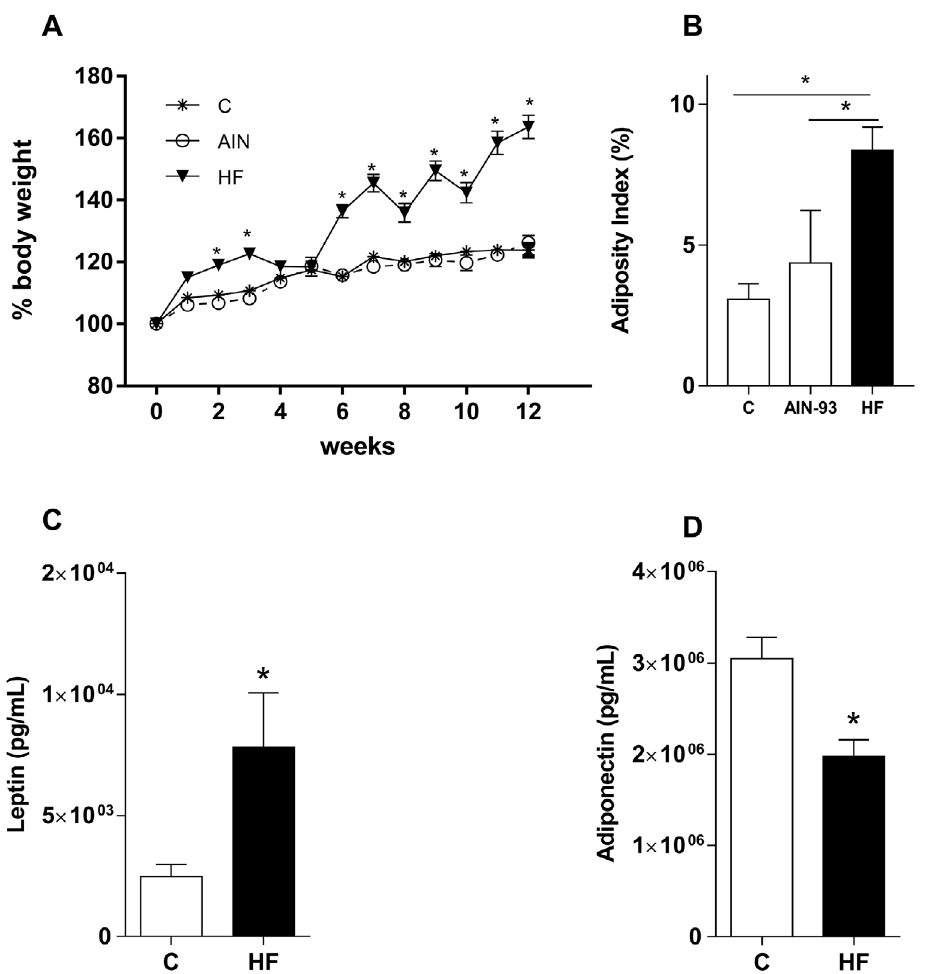
Figure 1- Mice fed HF diet presented body weight gain, increased adiposity, and alteration in the leptin and adiponectin concentrations. A: Weight parameters measured for 12 weeks, once a week, in groups of mice fed with control chow, AIN-93, or HF diet. B: Adiposity index measured in mice fed with control chow, AIN-93, or HF diet after 12 weeks. C: Leptin serum levels after 12 weeks, measured in mice fed with (C) control chow or HF diet. D: Adiponectin serum levels after 12 weeks measured in mice fed with a control diet or HF diet. N=5. The values (mean ± S.E.M) of all experiments were obtained from two independent experiments, with 30 mice. *p<0.05 versus control groups. The grouped analysis was performed by means of two-way ANOVA followed by Bonferroni in the body weight analysis. One-way ANOVA was followed by Newman-Keuls. The Student's t-test was performed when two groups were